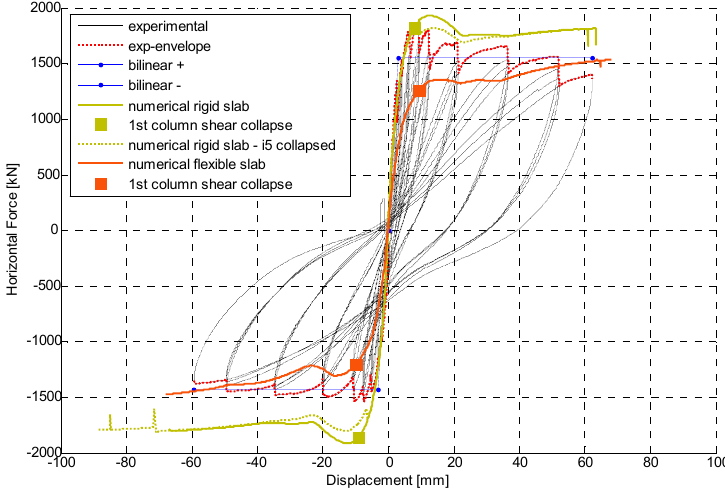
Figure 25. Capacity curves numerical and experimental.